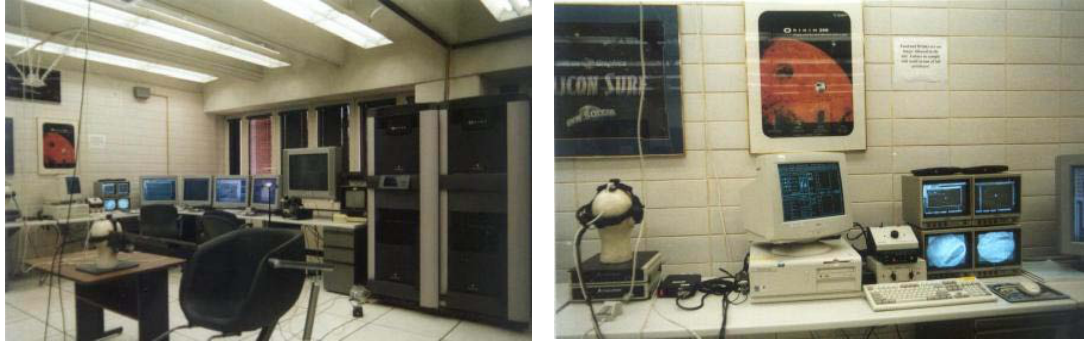
Figure 3. “Virtual Reality Eye Tracking (VRET) Laboratory at Clemson University”. Source: Own